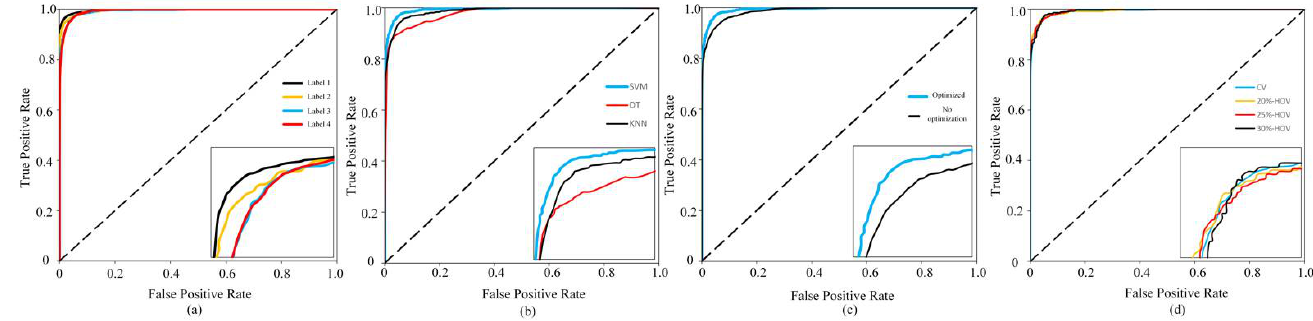
Figure 6. ( a ) ROC curves of models with different labels; ( b ) ROC curves of different algorithms; ( c ) ROC curves of models with or without transient error optimization; ( d ) ROC curves of models with different verification method.